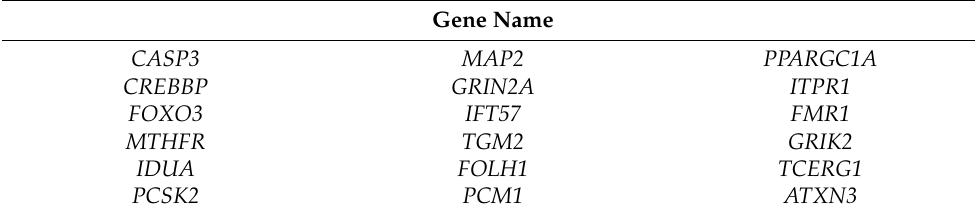
Figure 11. Venn diagram representing the common and exclusive gene targets of the HD CTD, Disease and Malacard databases and all DEGs identified from the HD-related datasets. Table 4. The HD-related hub